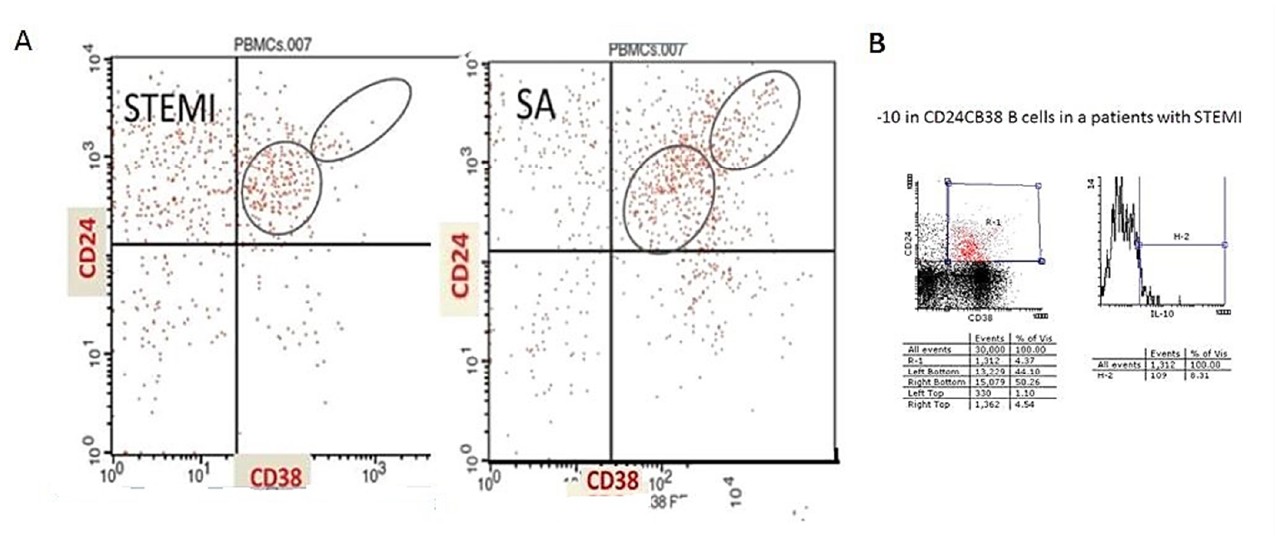
Figure 2. ( A ) Circulating CD24+CD38+ in a patient with stable angina and a patient with acute myocardial infarction. PBMCs isolated from patients with STEMI and SAP were stained directly ex vivo for the expression of CD20, CD24, and CD38. Representative flow cytometry plot of B cell subset gating showing CD20+CD24 hi CD38 hi and CD20+CD24 int CD38 int . ( B ) Intracellular IL-10 expression in CD24+CD38+ cells. Representative flow cytometry plot of IL-10 in CD24+CD38+ cells in a patient with STEMI.